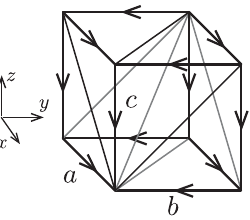
FIG. 7. The simplest triangulation of three-torus has a single vertex and three independent edges. Periodic boundary condi- tions are imposed on the